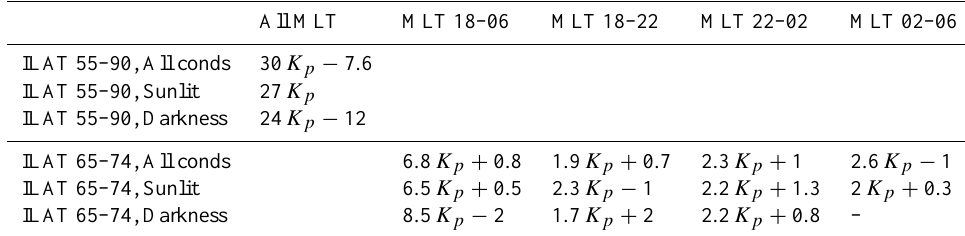
Table 1. Joule heating (GW) as a function of K p index in different hemispheric regions. All MLT